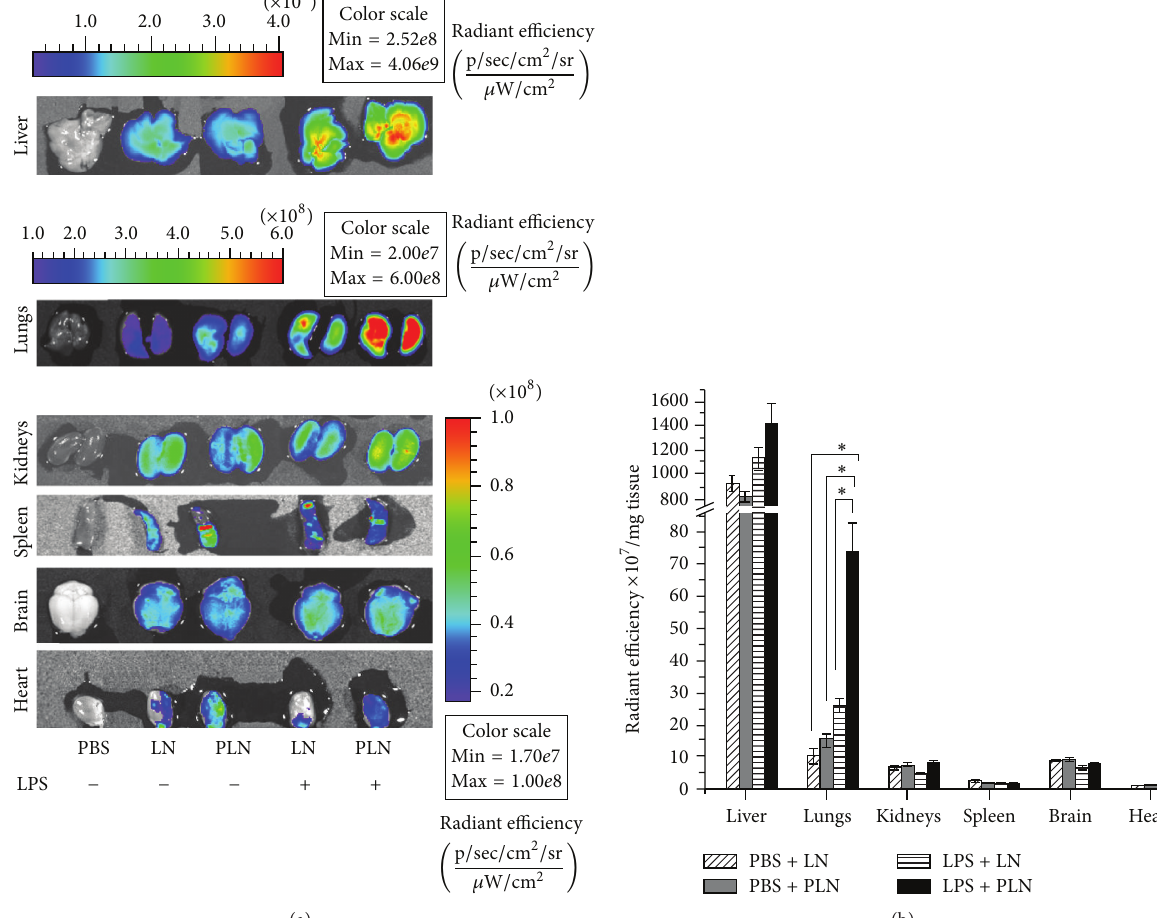
Figure 4: Localization of fluorescently labeled nontargeted or P-selectin targeted lipid nanoemulsions (LN and PLN, resp.) in different organs of C57BL/6 mice at 1 hour after i.v. administration in animals that were previously i.v. injected with PBS (control) or LPS (to induce systemic inflammation). The organs were visualized by an IVIS imaging system Caliper 200 at 𝜆 of nanoemulsions accumulation in the investigated organs was done using region-of-interest (ROI) function of Living Image software (b). Values are shown as radiant efficiency per tissue weight (mean ± SD). Three to five animals were used for each experimental group. ∗ 𝑝 < 0.05 , statistically